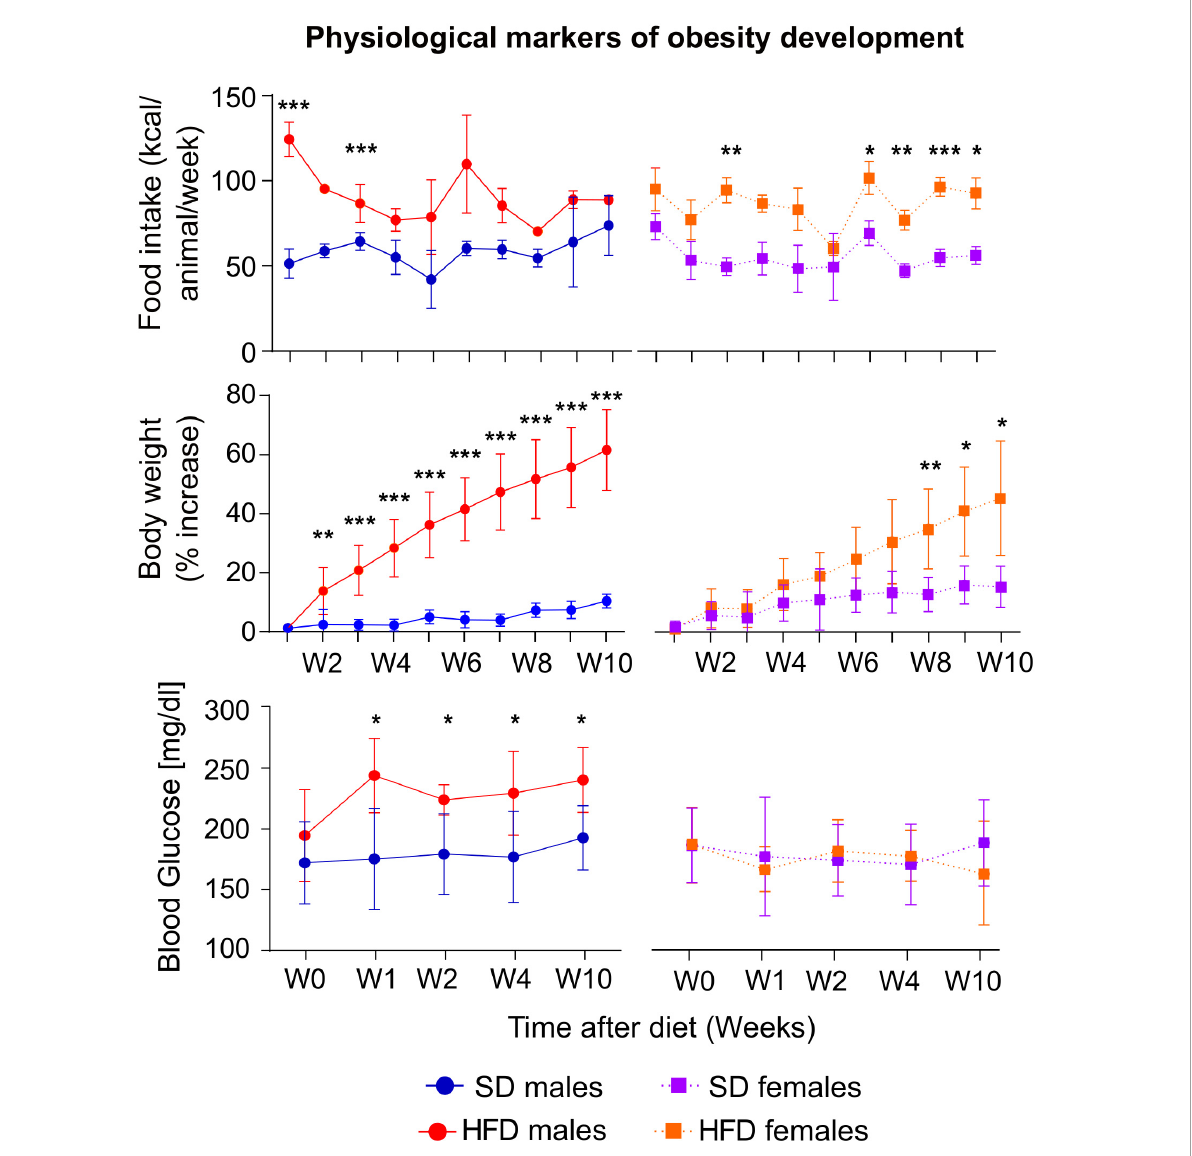
FIGURE1 Physiological changes during HFD or SD consumption. kcal/animal/week consumed (top), percentage of body weight changes (center), and blood glucose (bottom), on males (left) and females (right) for the HFD or SD cohorts, measured either weekly from week (W) 1 to week 10 from diet diversification, or measured before the MRI sessions in non-fasting conditions, for the blood glucose values. All values are expressed as (mean ± stdev) (* p < 0.05, ** p < 0.01, *** p < 0.001).